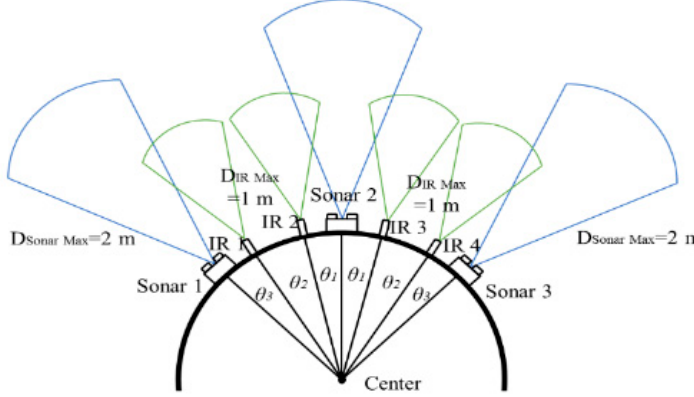
Figure 3. The configuration of the sonar and infrared sensors and their sensing ranges in Dr. Robot X80.